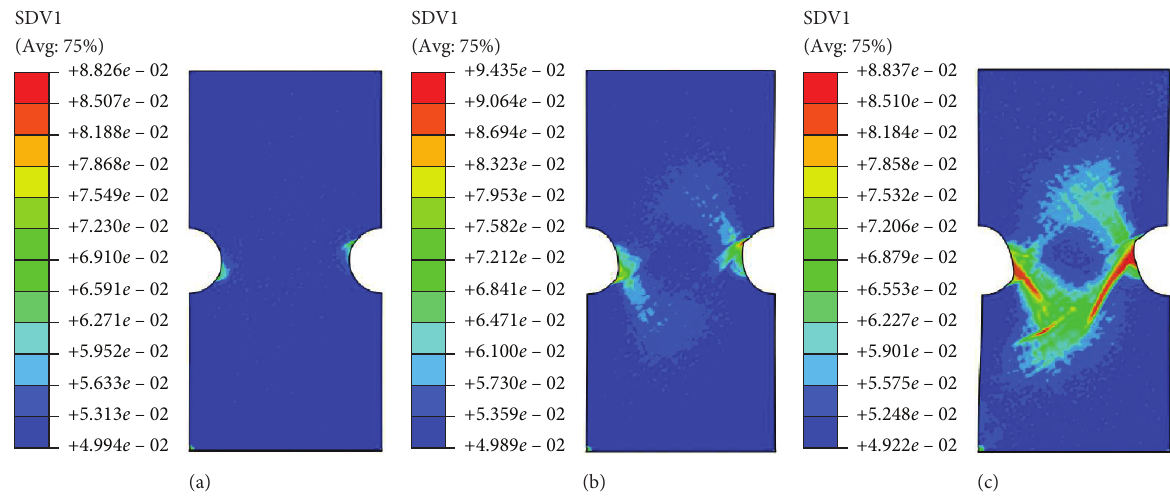
Figure 9: Shear banding illustration for specimen D under different tensile strain levels. (a) ε � 1.35%; (b) ε � 2.15%; (c) ε � 3.02%.